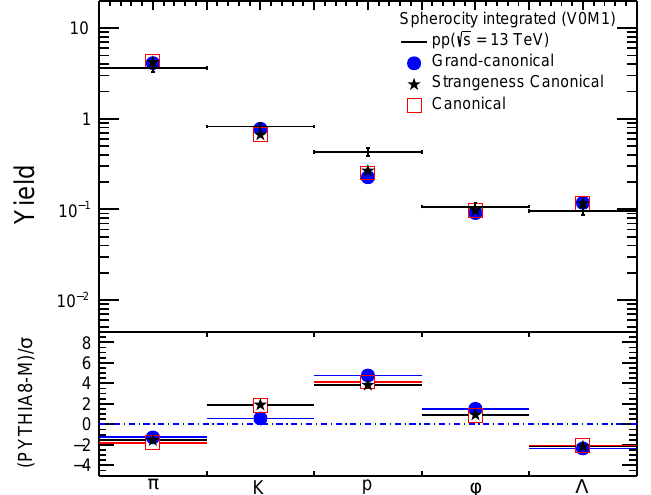
Figure 3. The upper panel shows the comparison of the identified particle yields in pp collisions at √ s = 13 TeV for spherocity integrated events at the highest multiplicity class with the thermal model using the grand canonical, strangeness canonical, and canonical ensembles. The lower panel shows the deviation from the fit results.